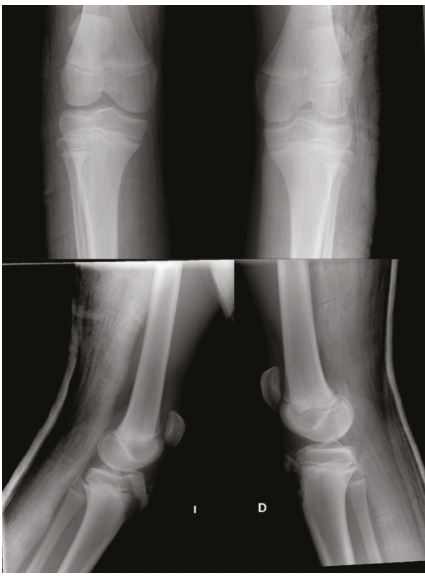
Figure 1: Plain radiographs of both knees. Right knee (D) showing an Ogden type IB fracture and the left one (I) type IIIA Ogden fracture.